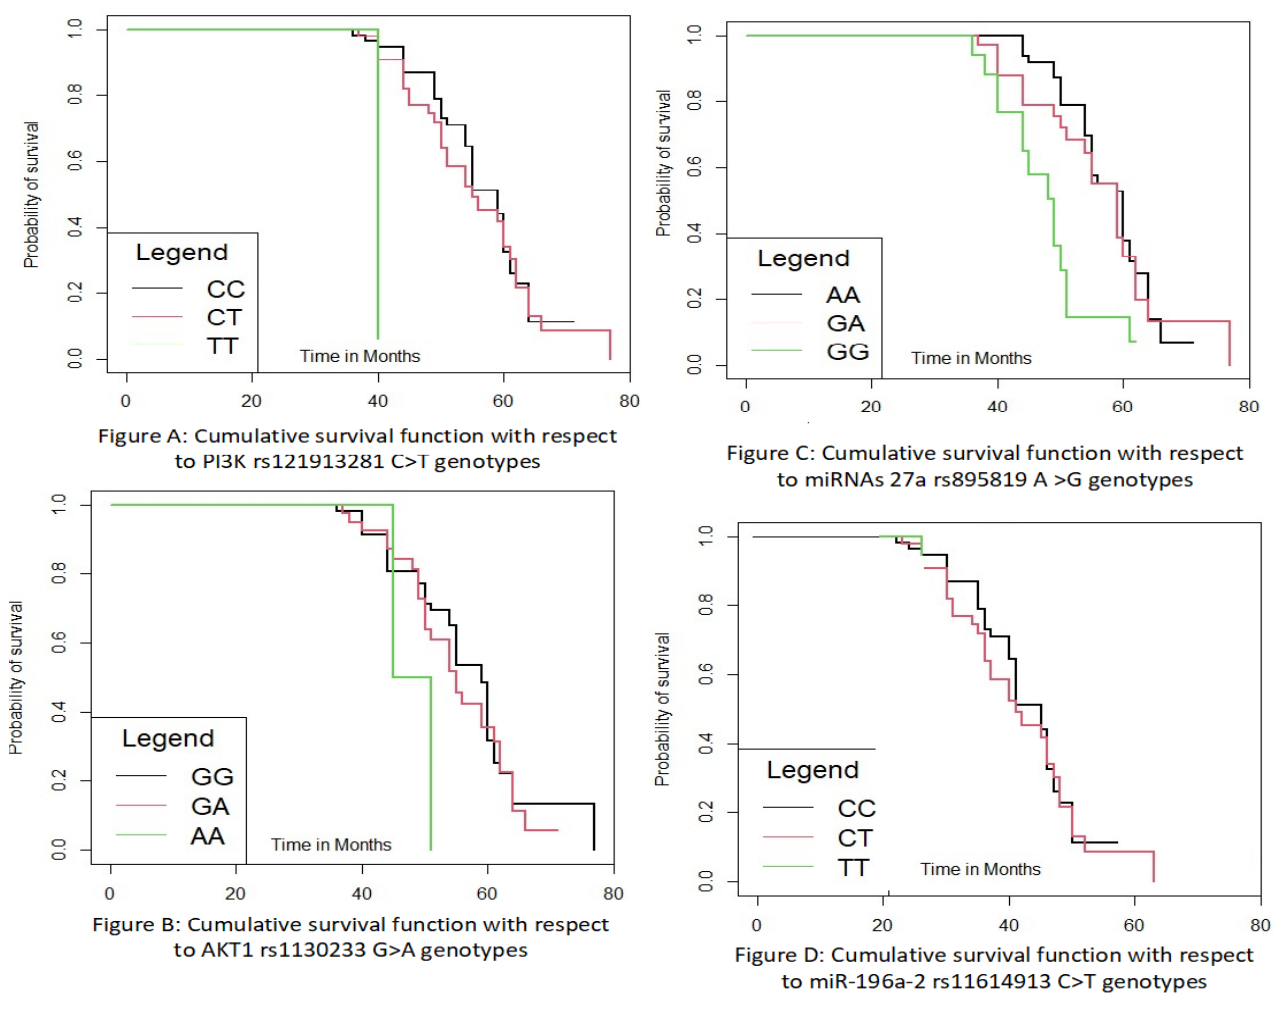
Figure 4. The figures represent the cumulative and overall survival by the Kaplan–Meier method, log-rank test, and Cox regression method of breast cancer patients according to gene polymorphism PI3K rs121913281 C > T ( A ), AKT1 rs1130233 G > A ( B ), miRNAs 27a rs895819 A > G ( C ), and miR-196a-2 rs11614913 C > T ( D ) polymorphism, log-rank test ( p < 0.05).